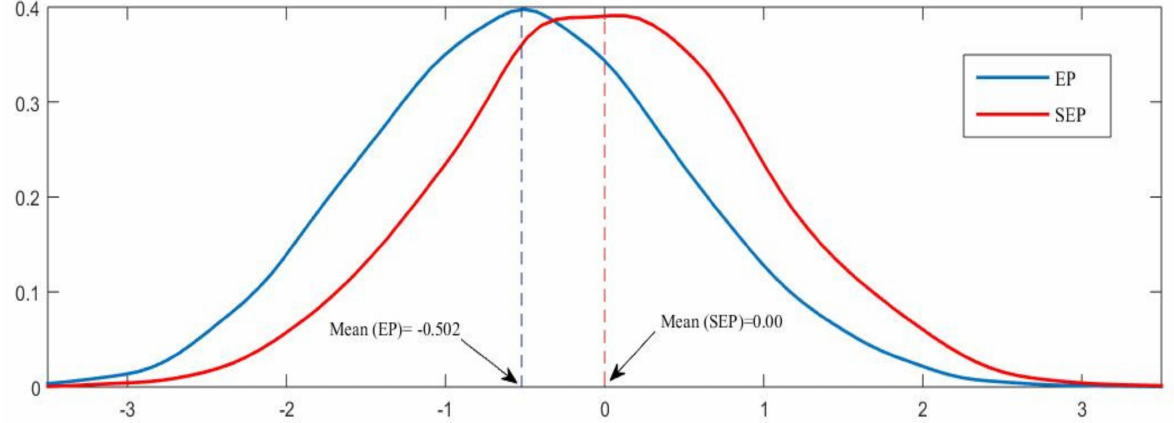
Figure 1. Kernel Densities of the EP and SEP Statistics. Notes: In Figure 1, we consider DGP1 (under the null hypothesis), with R = 200, P = 750, a rolling scheme and 5000 Monte Carlo